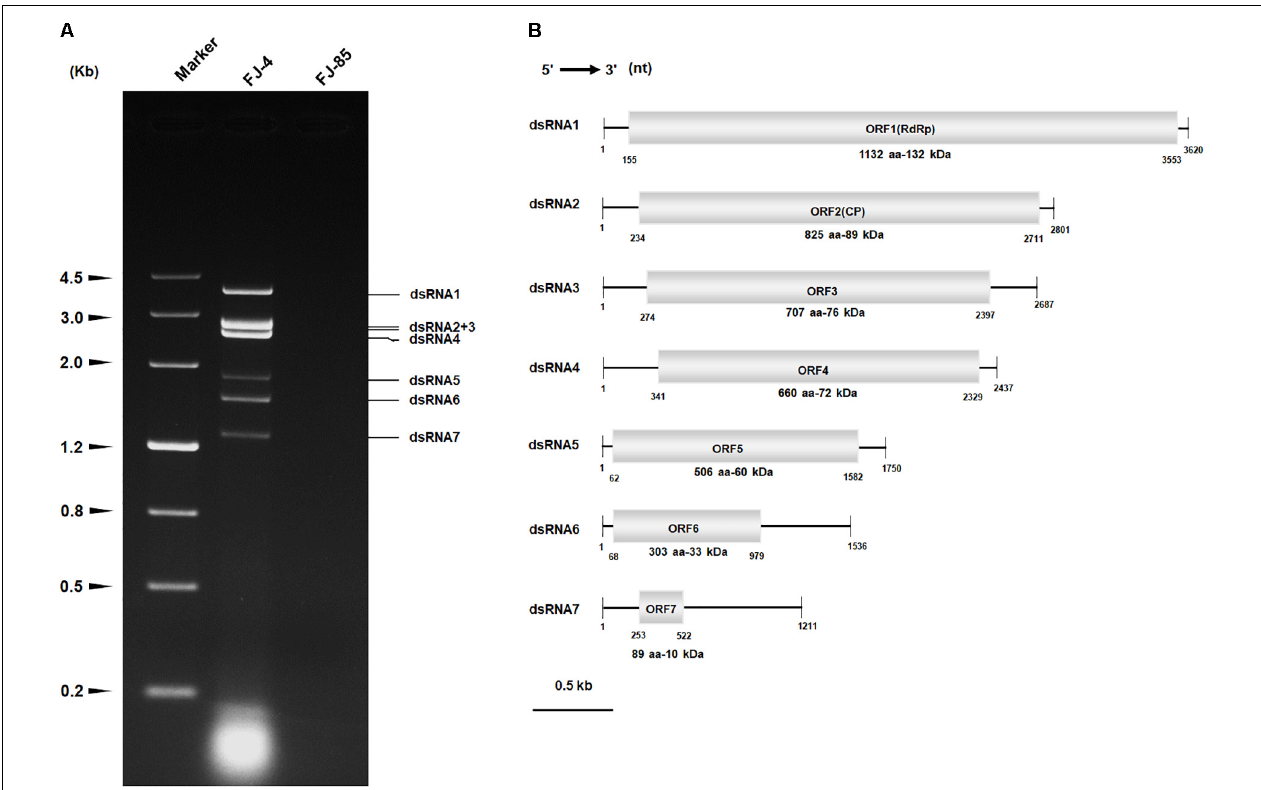
FIGURE 1 | Double-stranded RNA (dsRNAs) extracted from strain FJ-4 and the genomic organization of Colletotrichum fructicola dsRNA virus 1 (CfCV1). (A) 1.2% agarose gel electrophoretic profiles of dsRNA preparations extracted from strains FJ-4 and FJ-85 after digestion with DNase I and S1 nuclease. (B) Genomic organization of dsRNA1–7 of